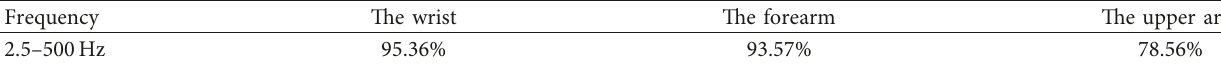
Table 4: The goodness of fit at different sets between the Measured and the Modeled.